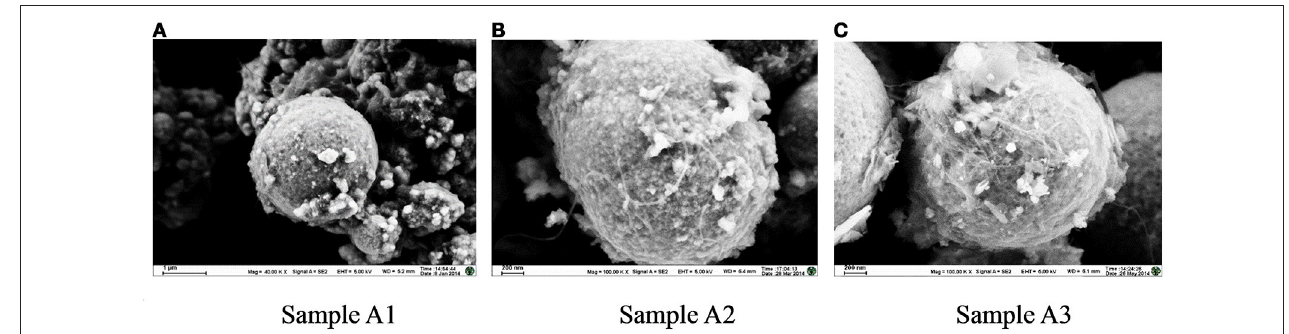
Frontiers in Materials | www.frontiersin.org